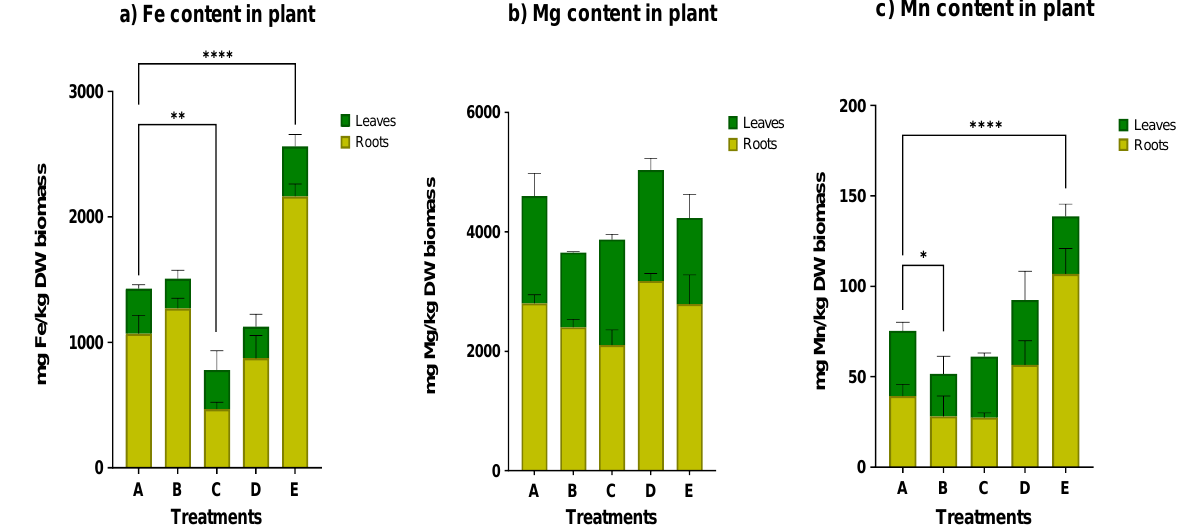
Figure 6. Concentration of ( a ) Fe, ( b ) Mg and ( c ) Mn in plant tissues for all treatments (star indicates the level of significance: * for p < 0.05, ** for p < 0.01, **** for p < 0.0001).